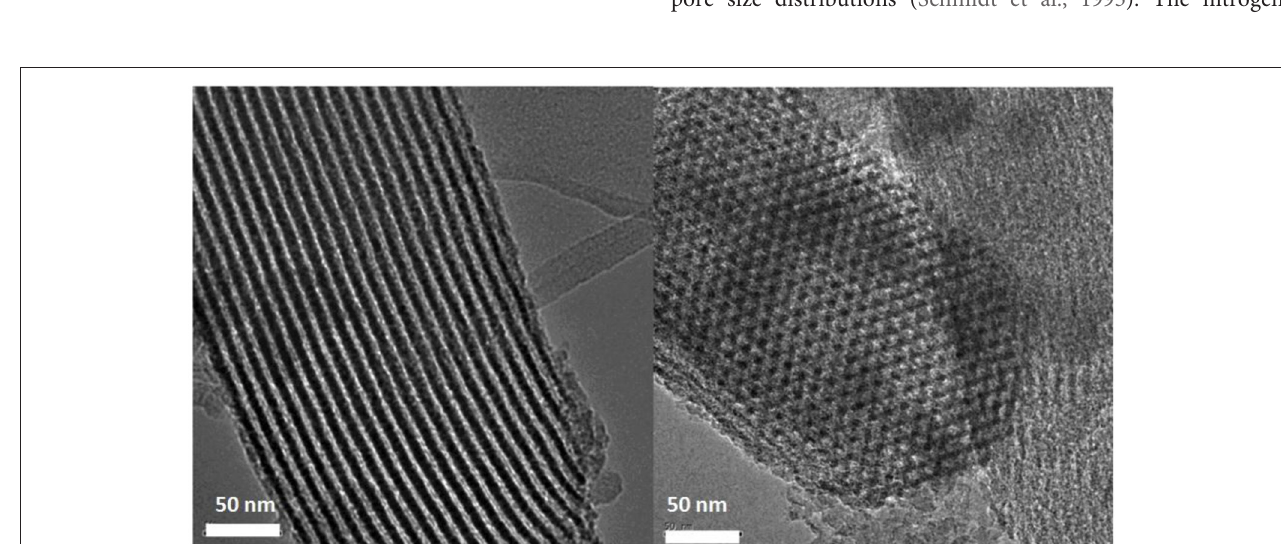
FIGURE 2 | TEM images of sample of